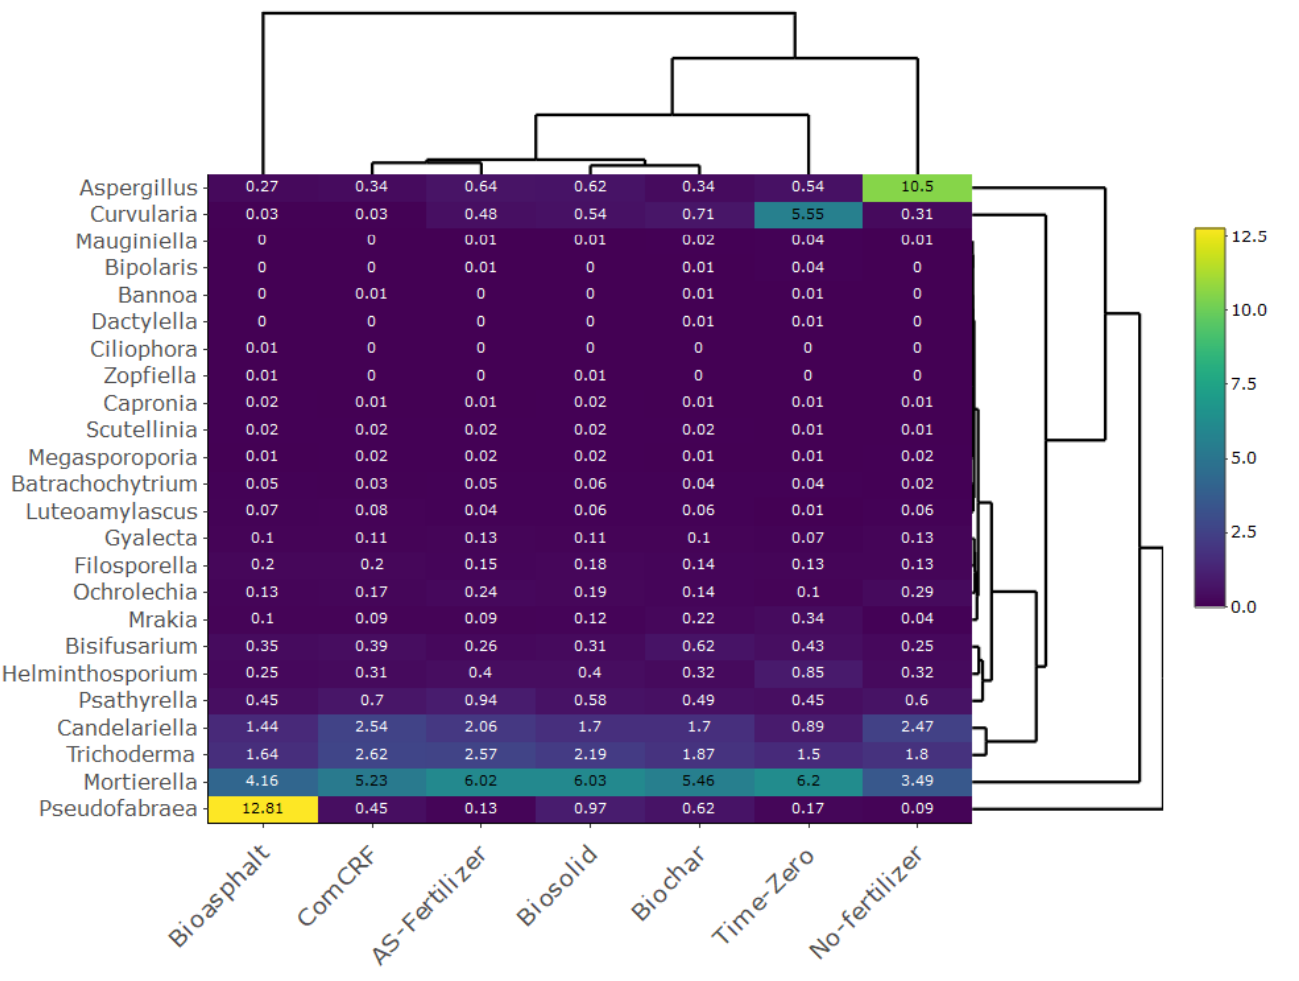
Figure 3. Heatmap showing the distribution of fungal genera across the treatments using “ hclust ” hierarchical clustering algorithm.